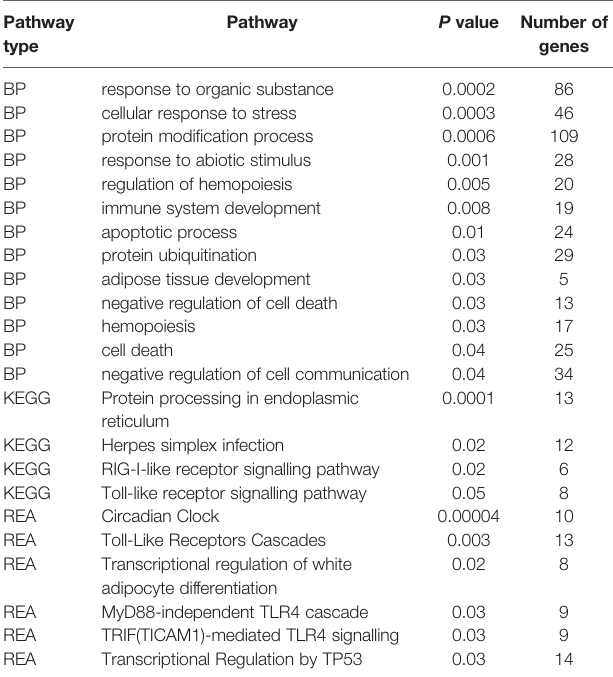
TABLE 2 | Selected pathways overrepresented in response to F. hepatica at 2 wpi (infected vs control analysis), as identi fi ed by gPro fi